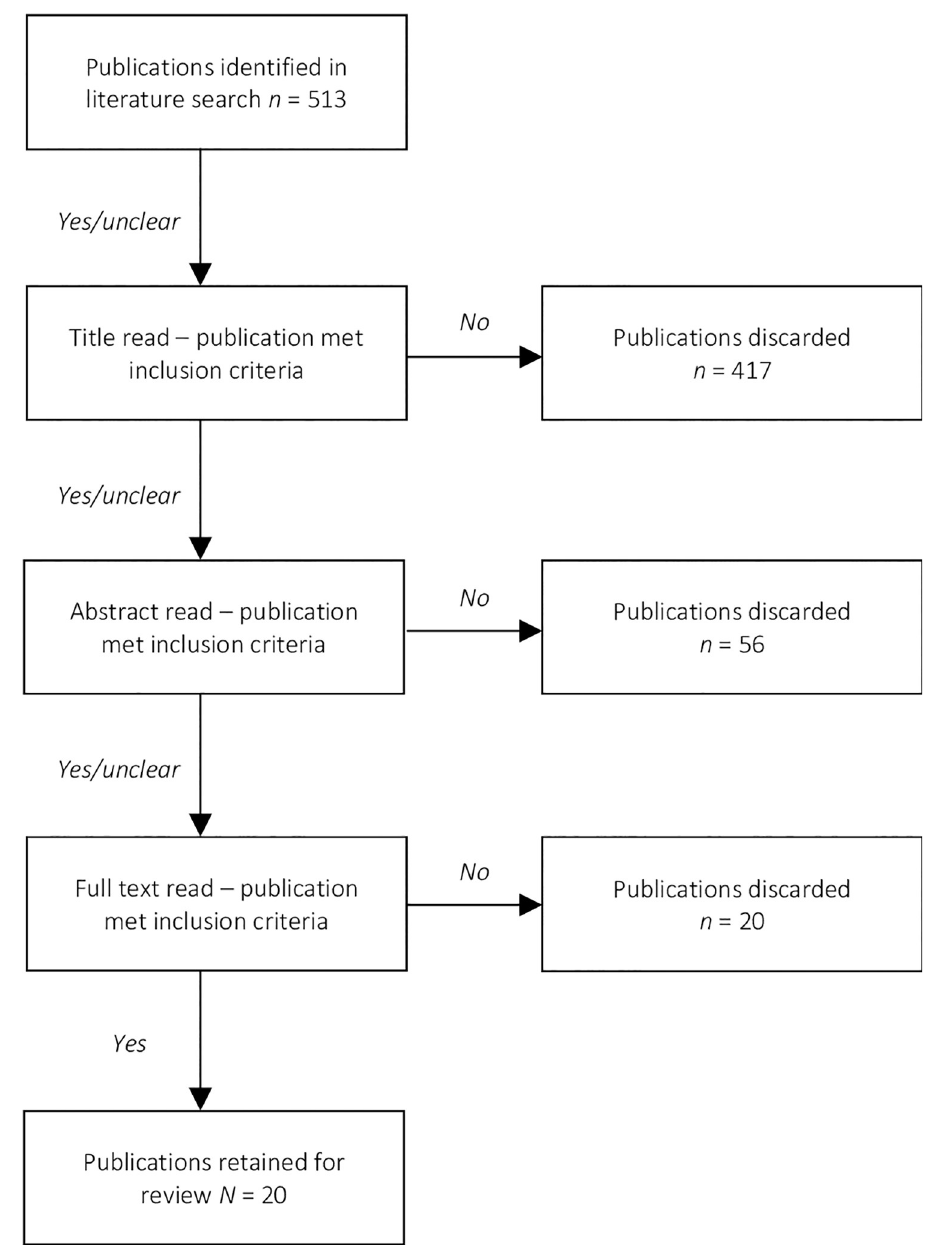
Fig 1. Flow chart for each step of article evaluation and